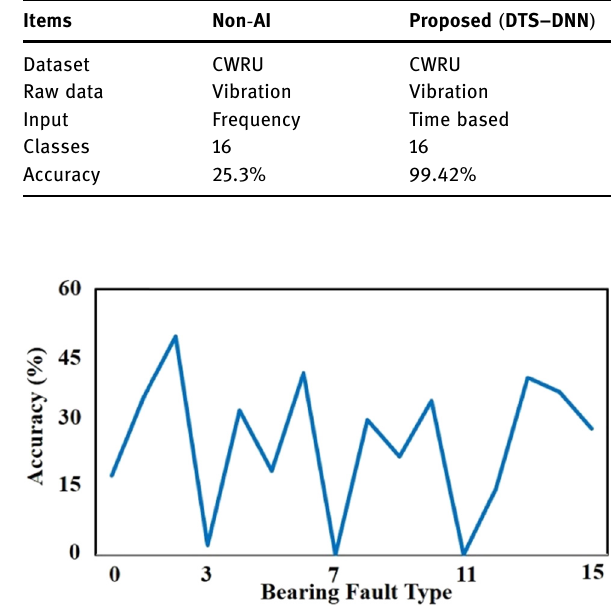
Figure 18: Frequency domain signal ( broken ball ) .